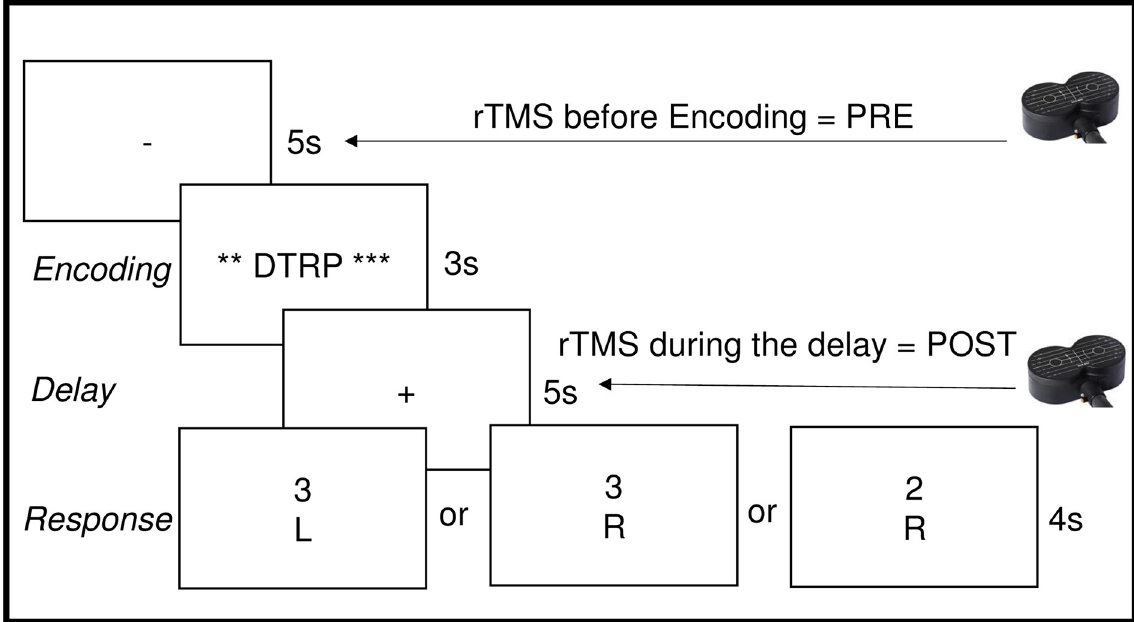
Fig 3. Schematic illustration of DRAT. One trial is shown with an array of 4 letters to encode, followed by a 5s delay period, during which participants had to maintain and reorganize the letters into alphabetical order. Examples of the 3 possible responses are shown at the bottom: “New”: the letter was not in the original array; “Valid”: the letter was in the array and the number represented the correct position in the alphabetical order; “Invalid”: the letter was in the array but the number did not match the correct serial position when alphabetized.